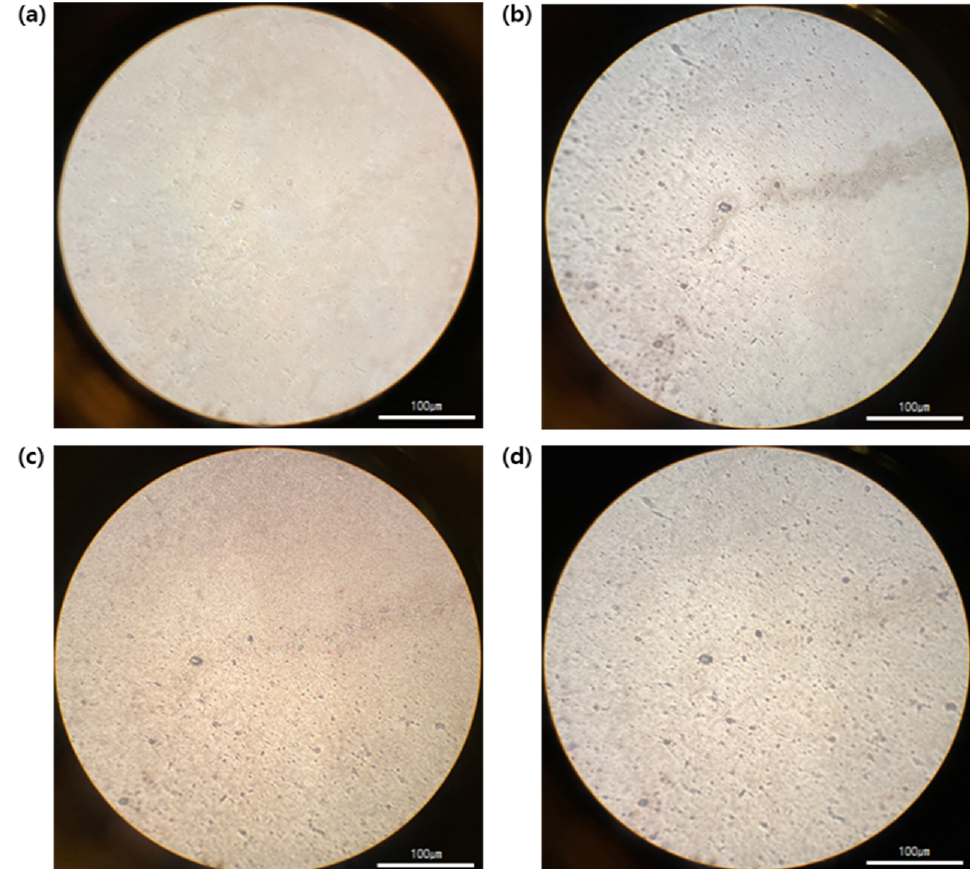
Figure 6. Microscopic images of the surfaces of the ( a ) PET film, ( b ) Mo layer in the Mo/PET film, ( c ) Al layer in the Al/Mo/PET film, and ( d ) Mo layer in the Mo/Al/Mo/PET film.